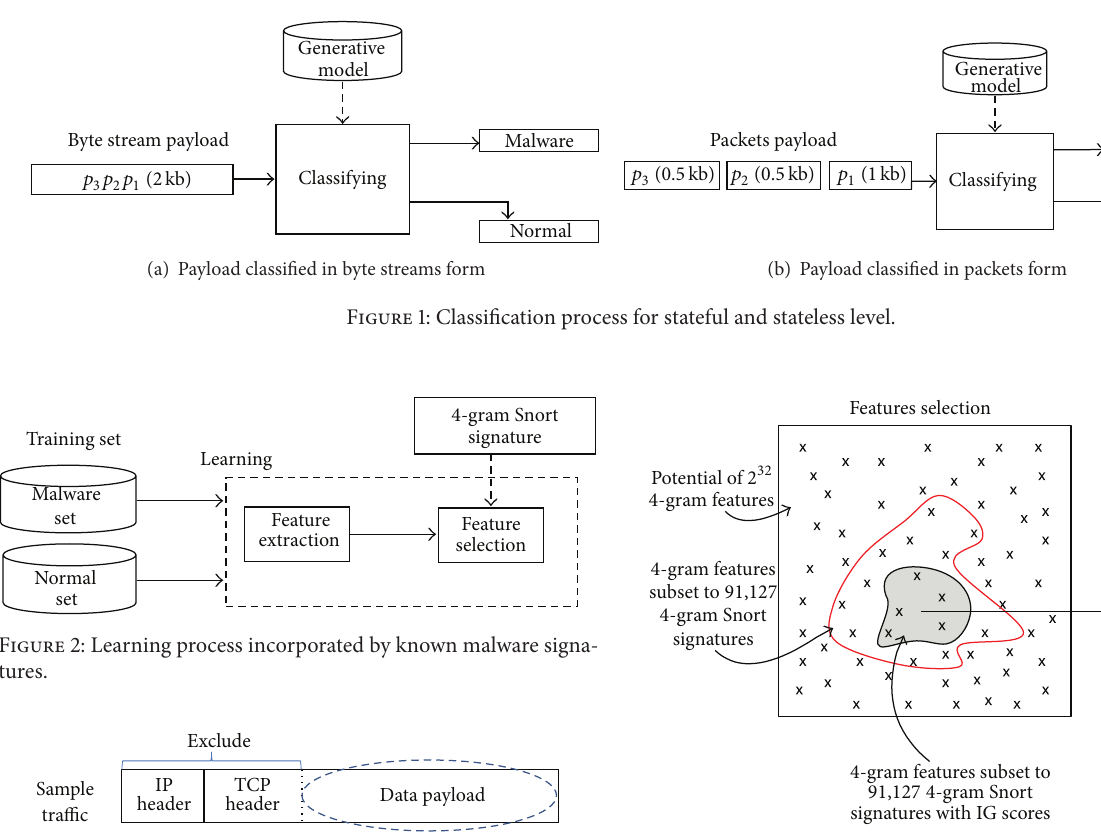
Figure 4: Training dataset based on selected features (subset of Snort signatures) with high